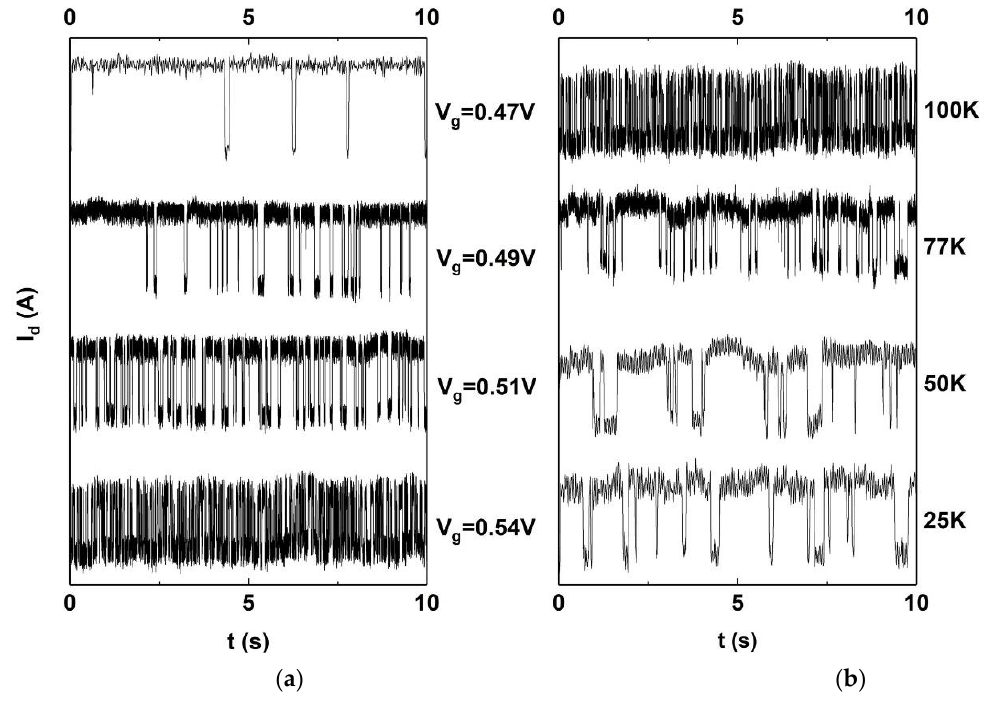
Figure 3. Time-domain graphs of RTN. ( a ) varying 𝑉 𝑔 at 100 K; ( b ) varying 𝑇 at 𝑉 𝑔 = 0.54 V.